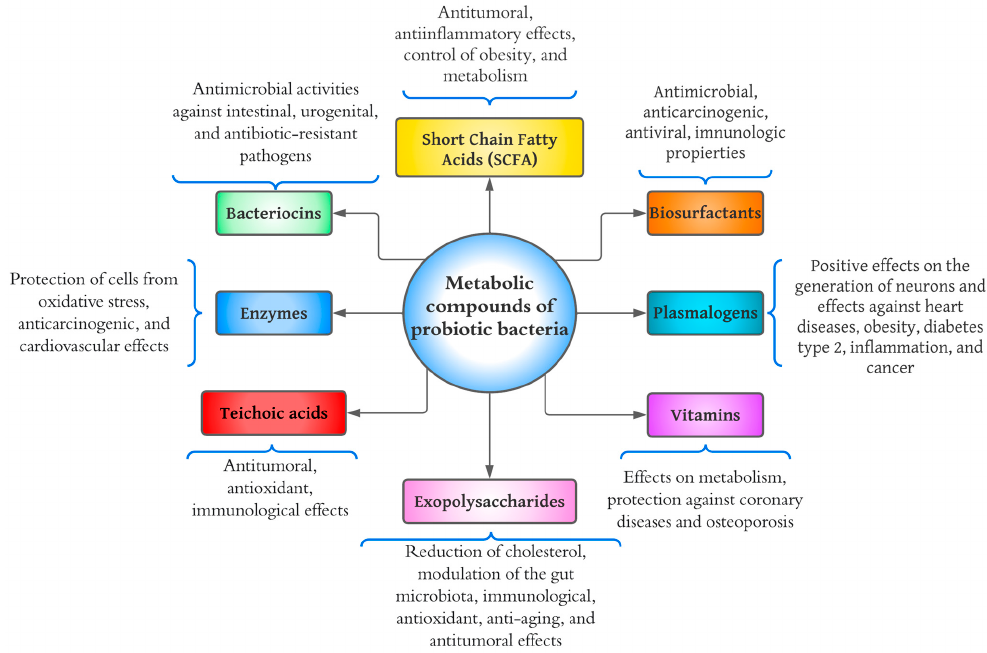
Figure 3. Diagram of health benefits of metabolic compounds of probiotic bacteria.